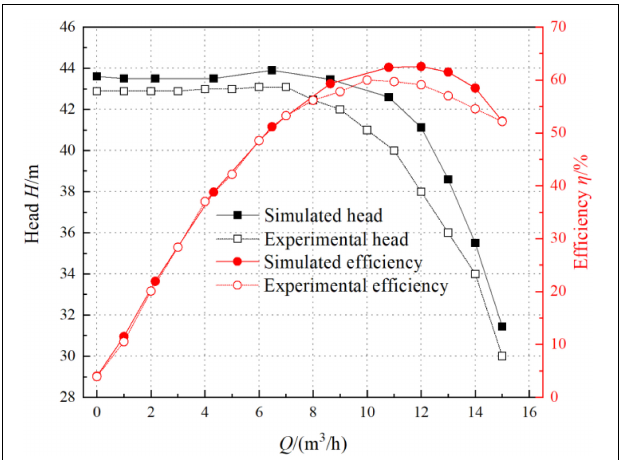
FIGURE 6 | Comparison of external characteristics between simulated and experimental